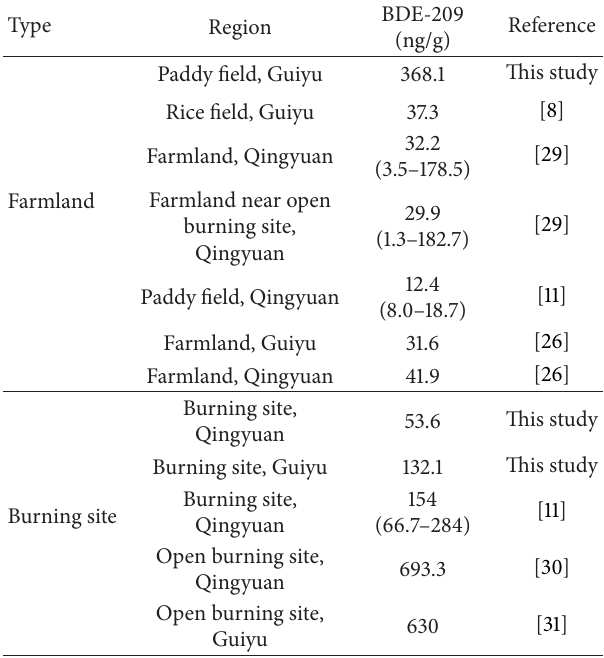
Table 2: Procedural, spiked blanks and recovery test of soil samples.